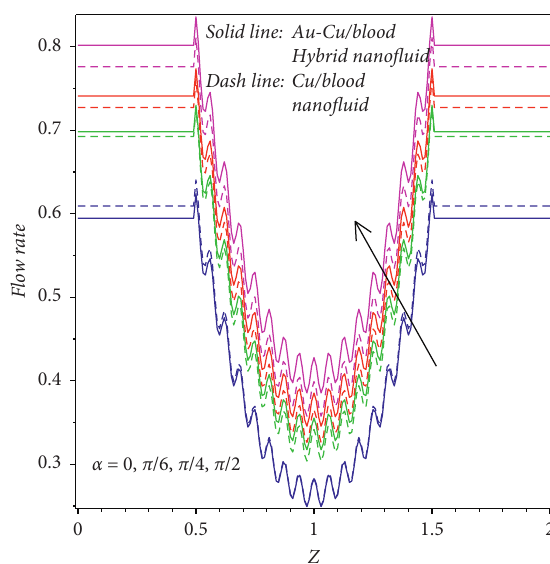
Figure 23: Behaviour of α on λ .